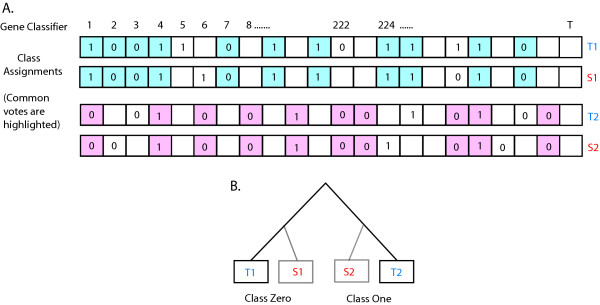
Procedure for building a dendrogram. Using the distance metric shown in equation 1, we determine a similarity score between two samples that reflects the number of common votes provided by the same informative genes. A. Based on this score, samples T1 and T2 in the training set form a bifurcation note representing their respective classes. B. Unseen samples S1 and S2 are placed on this node according to their similarity with T1 and T2.